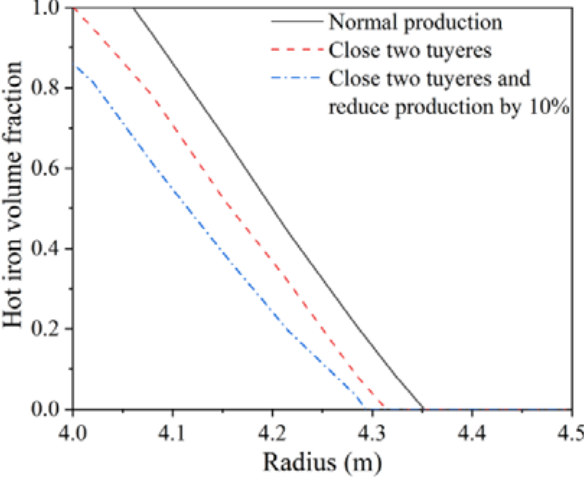
Figure 11. The volume fraction of hot iron on the evaluation line after tuyere closing.